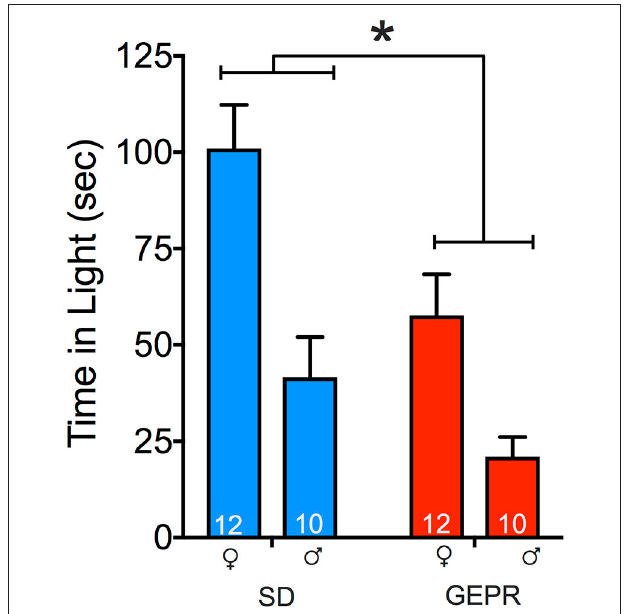
FIGURE 3 | Light-dark transition test. GEPR-3s displayed reduced time spent in the light compartment [* F (1,40) = 10.1, P = 0.003] and males spend less time in the light than females [ F (1,40) = 22.8, P < 0.0001]. Animals were initially placed in the light side of the apparatus; total test time was 5min. Pairwise comparisons indicated a sex effect in both strains ( Ps < 0.05, Holm-Sidak corrected), and the strain difference was significant for females, but not males ( P < 0.05, Holm-Sidak corrected). Figures show mean and standard error of the